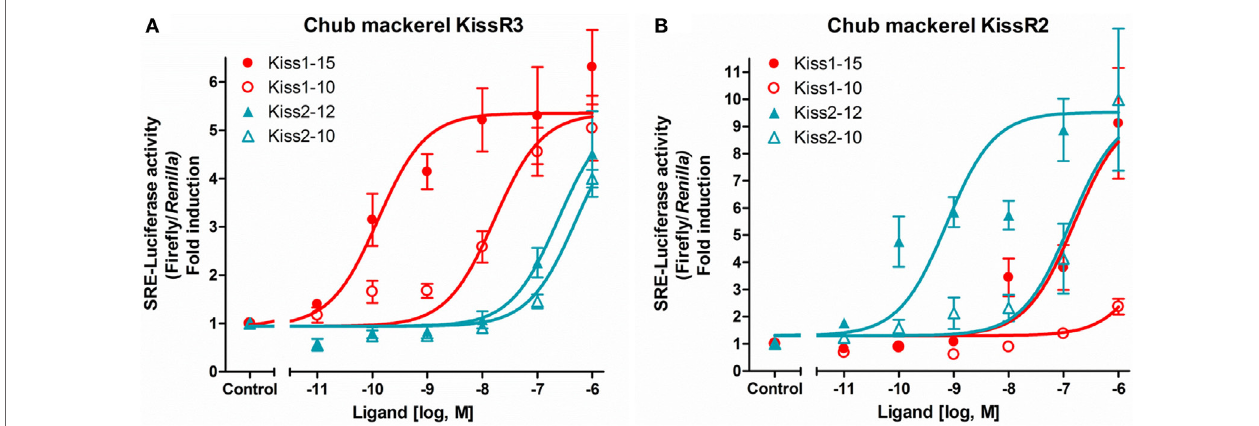
FigURe 1 | Ligand selectivity of the chub mackerel (cm) kisspeptin receptors. KissR3 (A) and KissR2 (B) , each together with SRE-Luc. Transfected cells were treated with graded concentration of each peptides. The data are expressed as the ratio of changes in firefly luciferase activity over the control Renilla luciferase activity. Each point was determined in quadruplicate and is given as a mean ± SEM. Modified from Ref. (36), by permission of